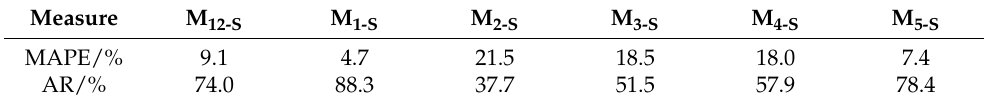
Figure 8. Spatial distribution of identical signs of GABP forecast precipitation anomalies, where rows and columns are the same as those in Figure 7 for various months of factors and months/season of precipitation forecast (e.g., ( e – h ) are for January factors, and ( m – p ) are for identical signs of precipitations of June, July, August and summer, respectively), respectively, and the grids with identical signs of forecast and observed anomalies are marked with crosses (i.e., “+”), through which the AR is calculated. Table 2. Basin-averaged evaluation measures of various GABP models using winter and spring monthly factors, where a model is denoted as “M”, with the subscripts of a number in addition to “ - S” representing a corresponding month of factors and summer precipitation forecast, respectively.